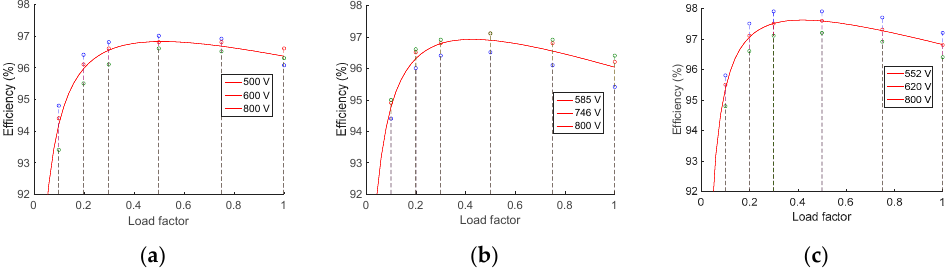
Figure 5. Efficiency curves calculated by means of the Dupont model. ( a ) Perfect Galaxy International Ltd EQX0250UV480TN. ( b ) Power-One ULTRA-750-TL-OUTD-4-US. ( c ) Power Electronics FS0900CU.